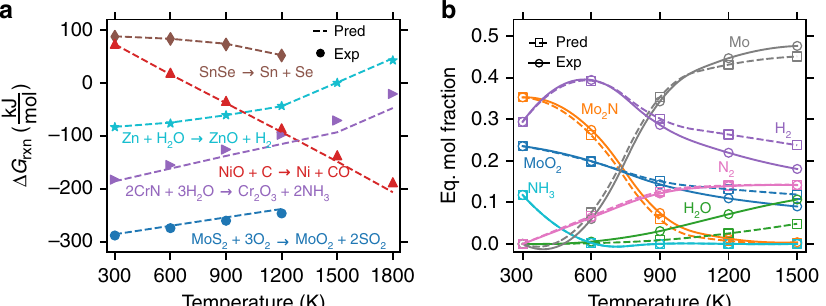
Fig. 4 High-throughput reaction engineering. a A comparison of experimental reaction energetics (labels) to those predicted using the machine-learned descriptor for G δ ( T ) (dashed curves). b Reaction product distribution between MoO 2 , Mo 2 N, N 2 , H 2 , H 2 O, and NH 3 based on Gibbs energy minimization subject to molar conservation and fi xed pressure of 1 atm. In both fi gures, pred applies the SISSO-learned descriptor to G δ ( T ) of the solid phases and experimental data for all other